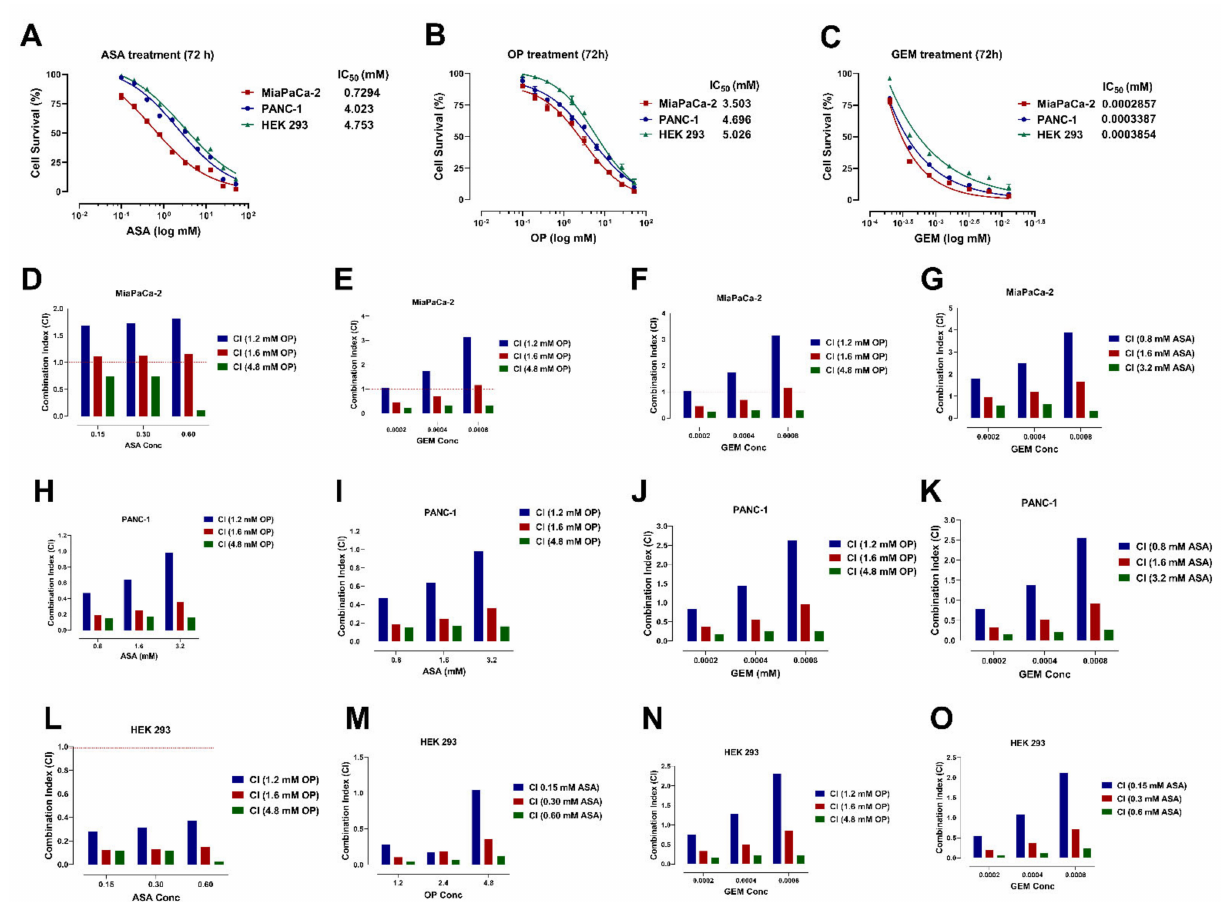
Figure 1. ASA, OP, GEM, and their combination reduce pancreatic cancer cell viability concentration- dependently. MiaPaCa-2, PANC-1, and HEK 293 cells, as immortalized non-malignant control cells, were plated in 96-well plates at 20,000 cells/well and treated with increasing concentrations of ( A ) ASA, ( B ) OP, and ( C ) GEM for 72 h to identify individual IC 50 values. The combination index (CI) was calculated to determine the degree of ASA and OP interactions, and their interactions with GEM on MiaPaCa-2 ( D – G ), PANC-1 ( H – K ), and HEK 293 ( L – O ) cells. The sum of the ratio of the concentration (mM) of each drug in the compound to the dose when used alone when the combination and drugs produce 50% (blue bar), 75% (red bar), and 95% (green bar) efficacies. The formula of the combination index (CI) = (D)1/(D χ )1 + (D)2/(D χ )2, where (D χ )1 and (D χ )2 represented concentrations (mM) of each drug alone to exert x% efficacies, while (D)1 and (D)2 are concentrations (mM) of the drugs in combination to elicit the same effect. CI < 1, = 1 and > 1 indicate synergism, additivity, and antagonism, respectively. Data are presented as mean ± SEM compared to the untreated control at day 0. Data are represented as the mean ± SEM of 3 independent experiments performed in triplicates. Abbreviations: ASA, aspirin; OP, oseltamivir phosphate; GEM, gemcitabine; IC 50 , half-maximal inhibitory concentration; SEM, standard error of the mean; CI, combination